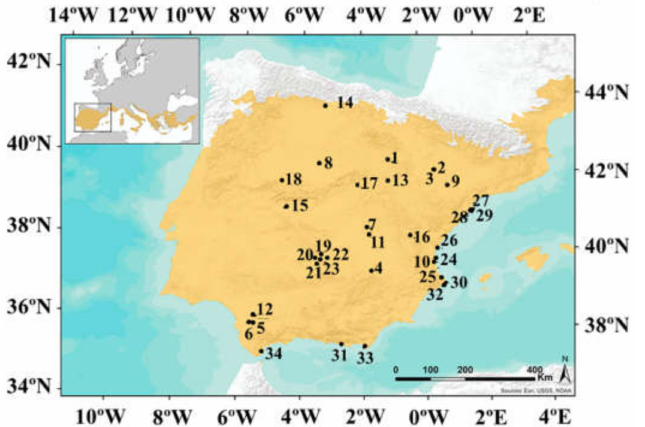
Figure 1. Location of the validation sites over Mediterranean biogeographical region of the Iberian Peninsula: (1) Laguna de Llanos de la Herrada, (2) Galacho de la Alfranca de Pastriz, (3) Galacho de El Burgo de Ebro, (4) Laguna del Arquillo, (5) Laguna Salada de Zorrilla, (6) Laguna de los Tollos, (7) Laguna de El Hito, (8) Laguna de Caballo Alba, (9) Laguna Salada de Chiprana, (10) Ullal de Baldov í , (11) Laguna de los Capellanes, (12) Laguna de Alcaparrosa,(13) Laguna de Judes, (14) Laguna de Campillo, (15) Laguna de Palancoso, (16) Laguna de Talayuelas, (17) Laguna Grande de la Puebla de Beleña, (18) Charca del Monte, (19) Laguna de Fuentillejo o La Posadilla, (20) Laguna de La Carrizosa, (21) Laguna de Almod ó var, (22) Laguna Blanca de Armagasilla, (23) Laguna de Caracuel, (24) Mallada de la Mata del Fang (l’Albufera), (25) Marjal de Pego-Oliva, (26) Marjal dels Moros, (27) Filtre Biologic l’Embut, (28) L’Encanyissada, (29) Alfacs marshes, (30) Senillar de Moraira, (31) Albufera Nueva de Adra, (32) Salinas de Calp, (33) Salinas de Cabo de Gata, and (34) Palmones marshes. Brown area indicates the Mediterranean biogeographical region of the Iberian